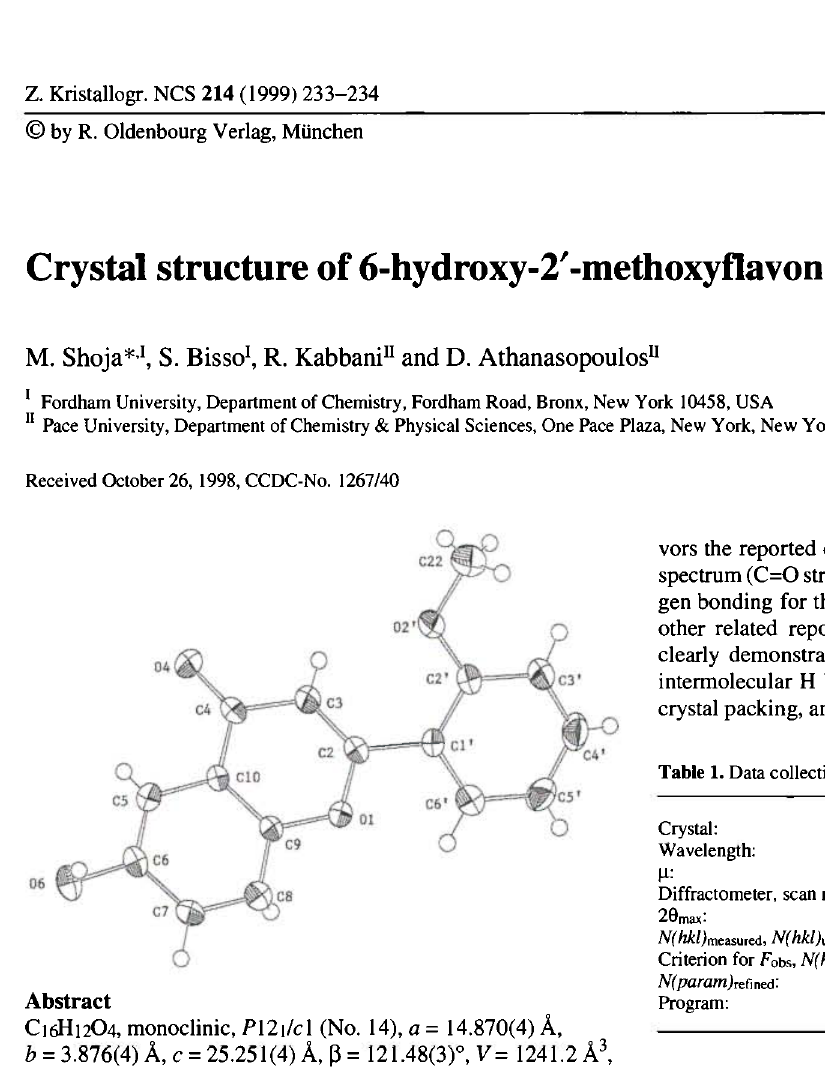
Table 2. Atomic coordinates and displacement parameters (in A 2 ).